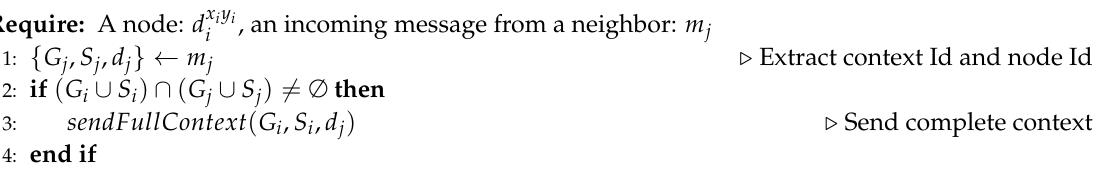
Algorithm 2 SACAR pseudocode description (ii): reception of